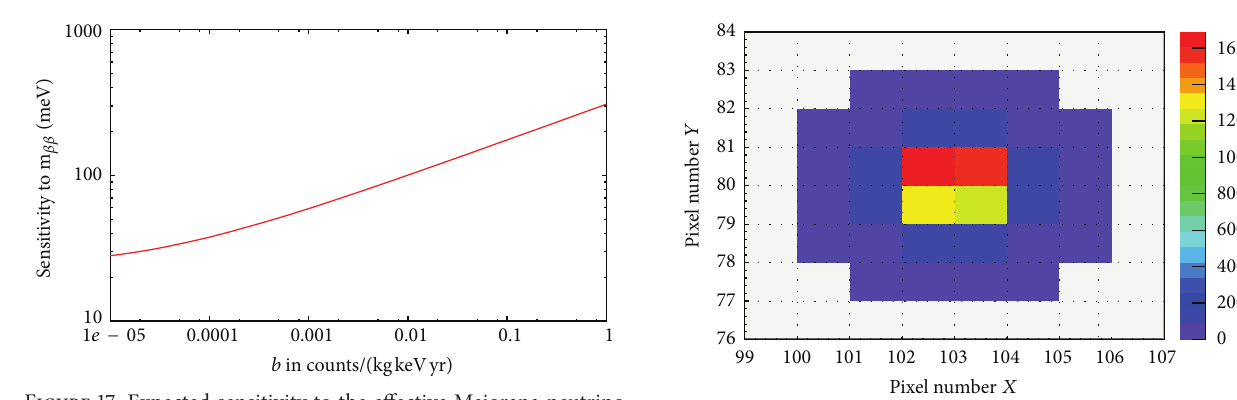
Figure 18: Measured image of the energy deposition of a 5.8MeV 𝛼 -particle impact on the common electrode side, recorded with a 110 𝜇 m pixel pitch Timepix detector with a 1mm thick sensor